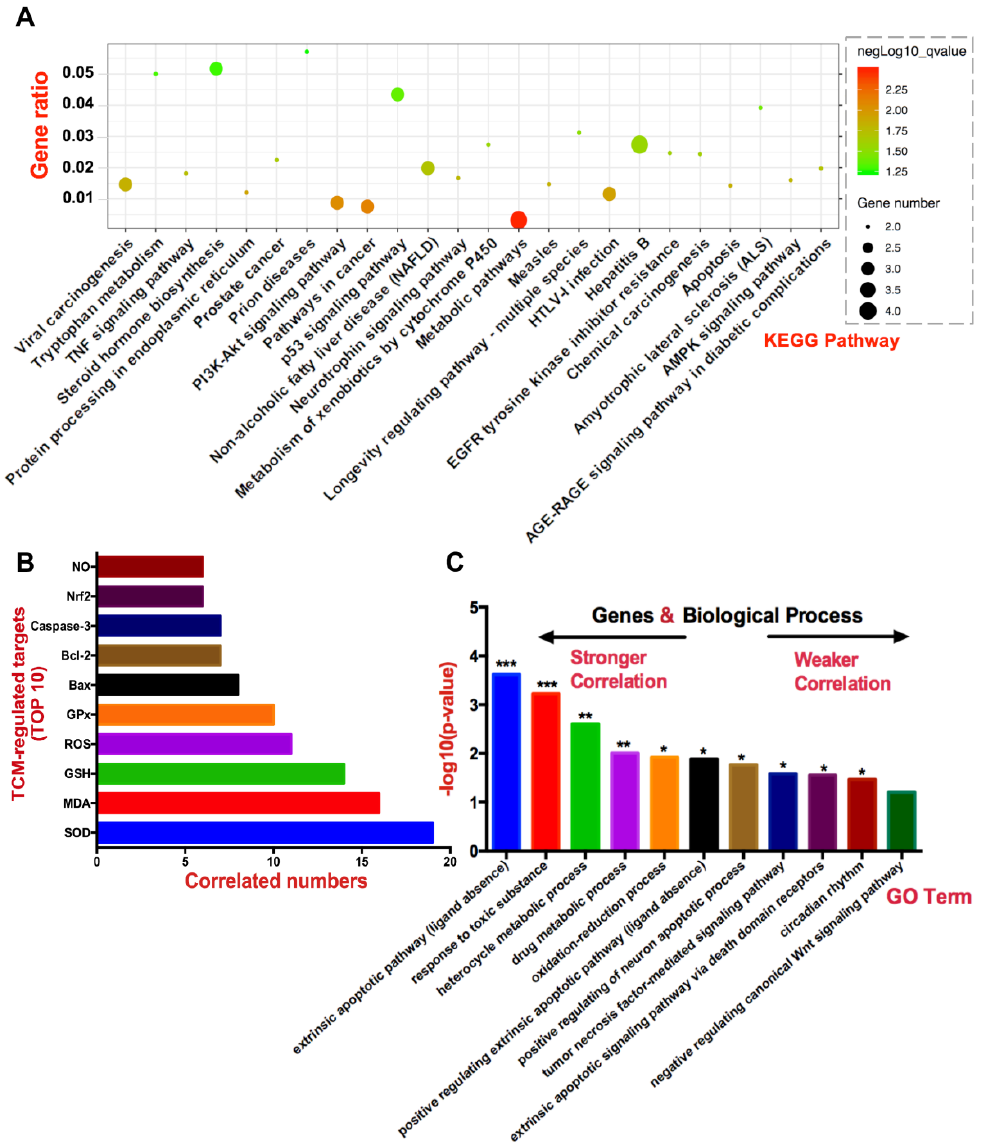
Figure 3. Target mining for TCM-caused oxidative hepatotoxicity by network pharmacology and bioinformatics enrichment analysis. ( A ) Scatter plot of enriched KEGG pathways statistics. The gene ratio illustrates the significantly expressed gene number to the total gene number in a certain pathway. ( B ) Identification of TCM-modulated targets for oxidative liver injury by network pharmacology. ( C ) GO analysis on the involvement of principal biological process. (*): − log10 ( p ) > 1.3; (**): − log10 ( p ) > 2, and (***): − log10 ( p ) > 3 versus background genes.